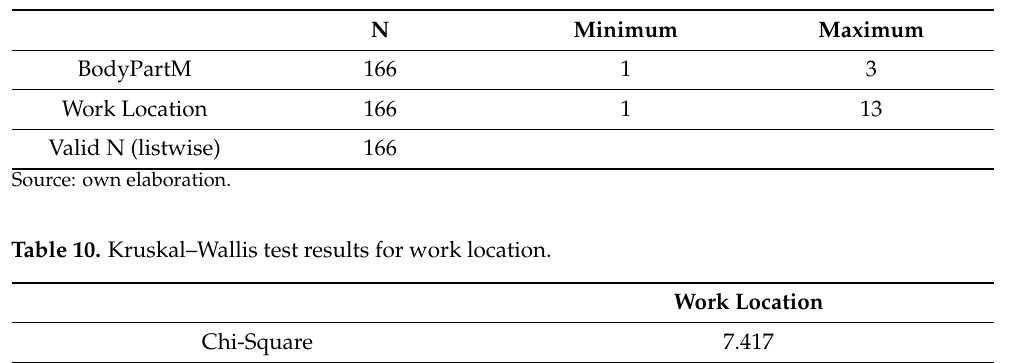
Table 9. Descriptive statistics: minimum and maximum.